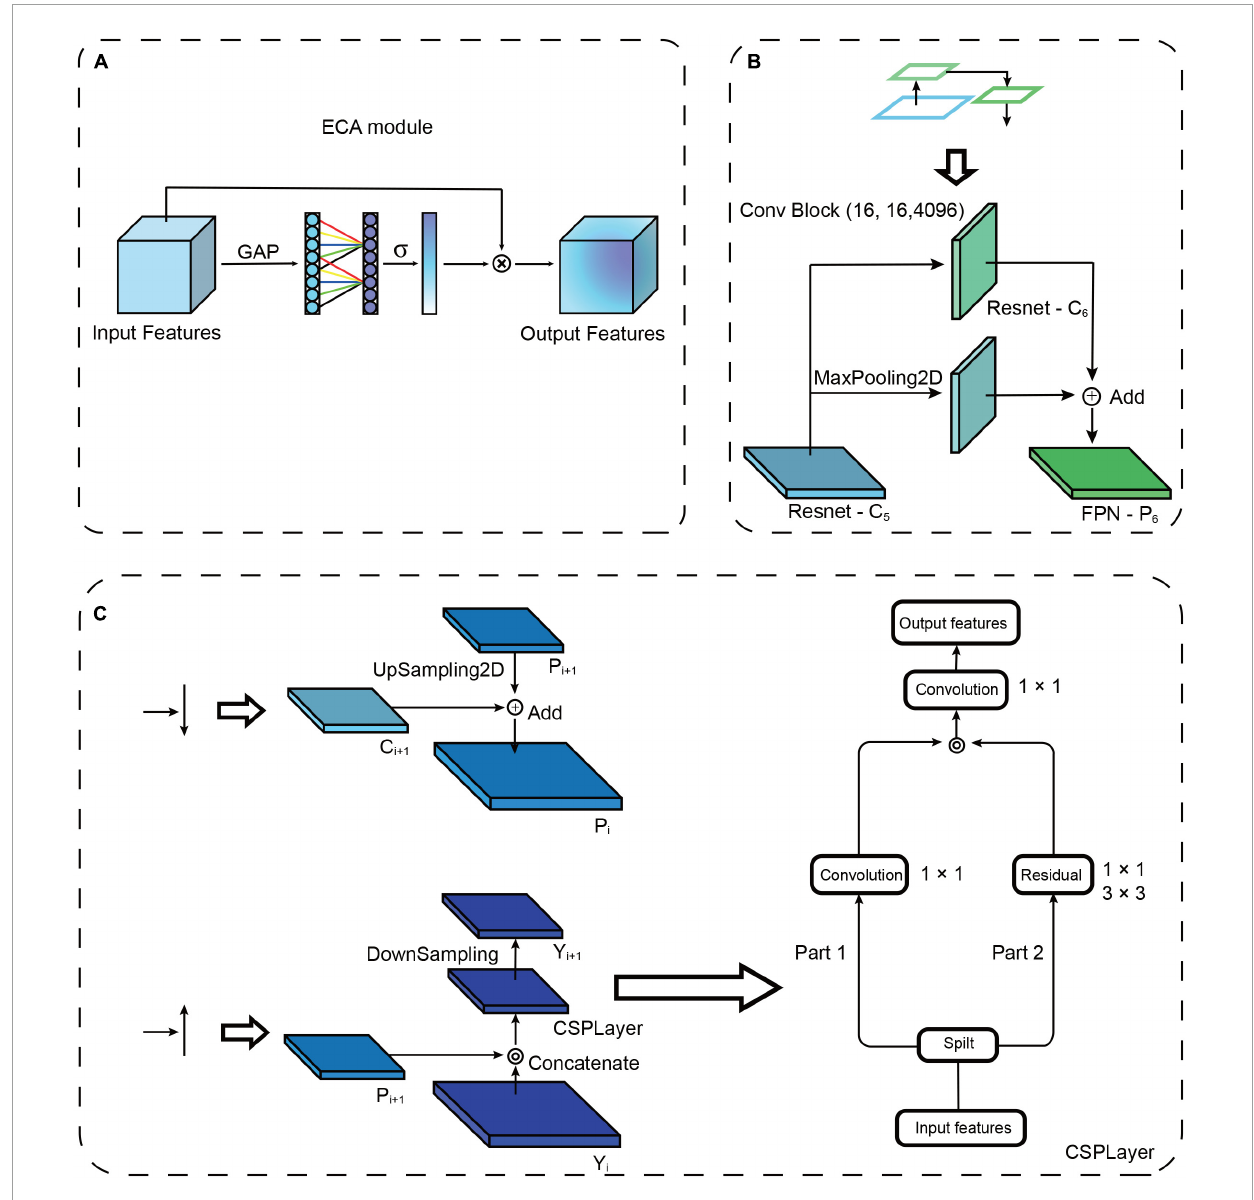
FIGURE2 Attention mechanism and path augmentation modules. (A) Diagram of efficient channel attention (ECA) module. GAP, Global average pooling. ⊗ : The output is combined with the input feature map. (B) Illustration of the structure of ResNet down-sampling path augmentation. (C) Left top: “Add” is used as the fusion method of up-sampling and lateral connection. Left bottom: “Concatenate” is used as the fusion method of down-sampling and the lateral connection. Right: Illustration of the structure of the